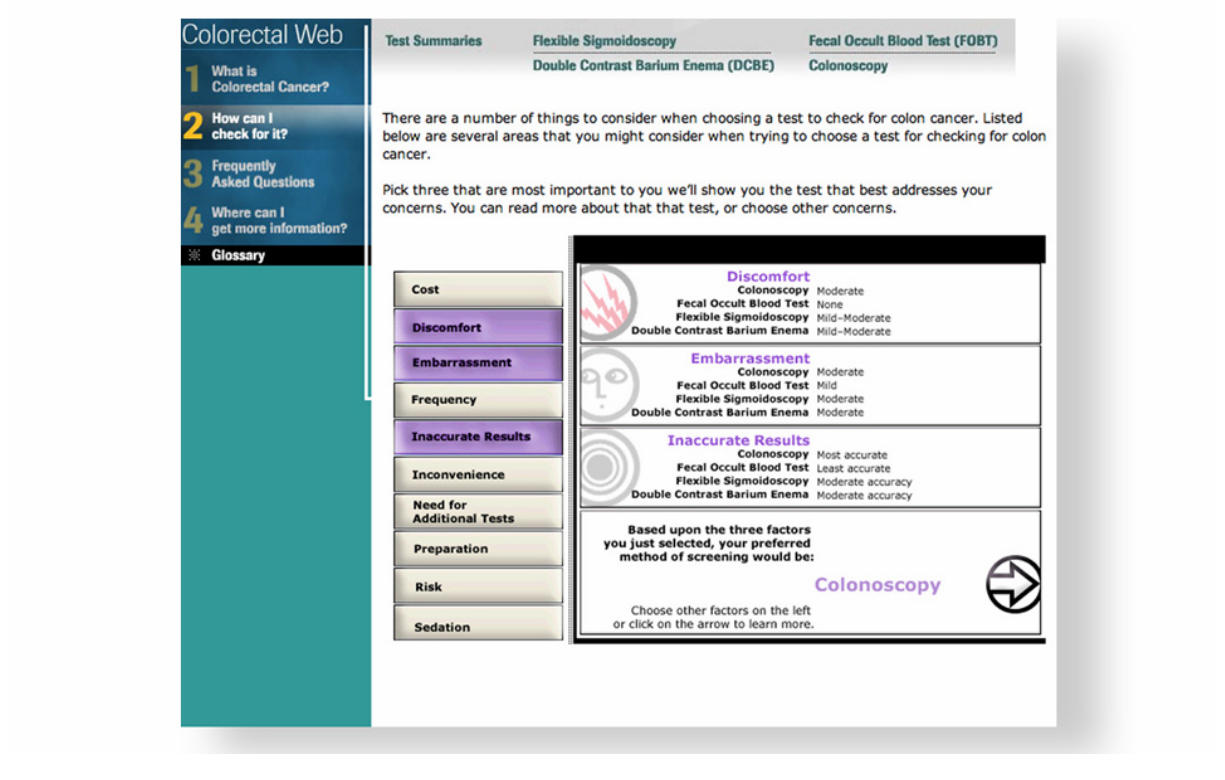
Figure 1. Colonoscopy selected as preferred screening method.